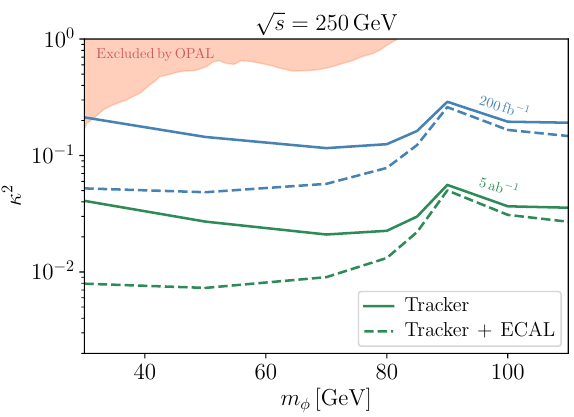
Figure 7 . Discovery reach for the coupling strength squared of new light scalars coupled to the Z -boson in a Z ( (cid:22) + (cid:22) (cid:0) ) (cid:30) recoil search at a future Higgs factory with 200 fb (cid:0) 1 and 5 ab (cid:0) 1 ! of integrated luminosity. The solid curves show the sensitivity for a tracking detector and the dashed curves for a general purpose detector with tracking and electromagnetic calorimeter. In the tracking-only detector the reach is degraded at low masses due to the signi(cid:12)cant 2 (cid:22) + ISR background, which could be largely eliminated by a photon veto a(cid:11)orded by a photon conversion layer and outer tracking element described in section 3.3. Also shown for reference are the analogous decay mode-independent bounds from OPAL